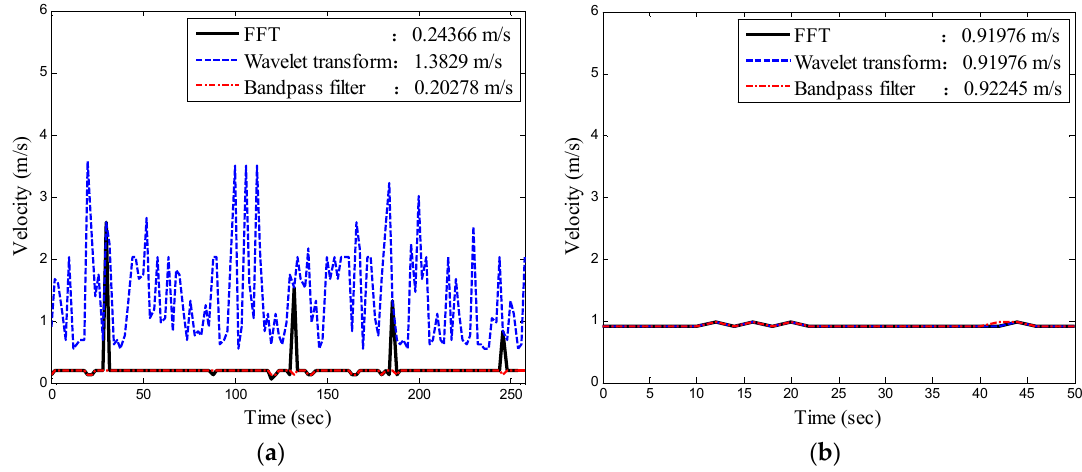
Figure 8. Comparison of the calculated results obtained using different analytical methods at a tilt angle of 30°: ( a ) speed = 0.2 m/s; and ( b ) speed = 1.0 m/s.